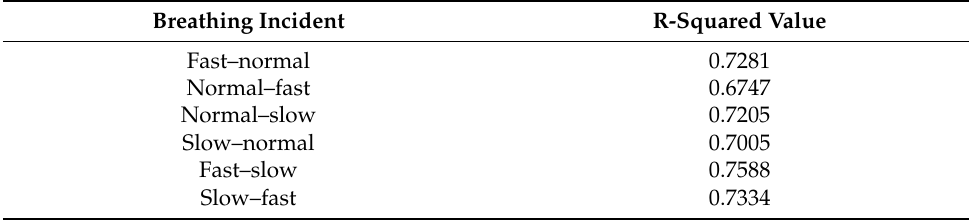
Table 4. R-squared analysis for different breathing